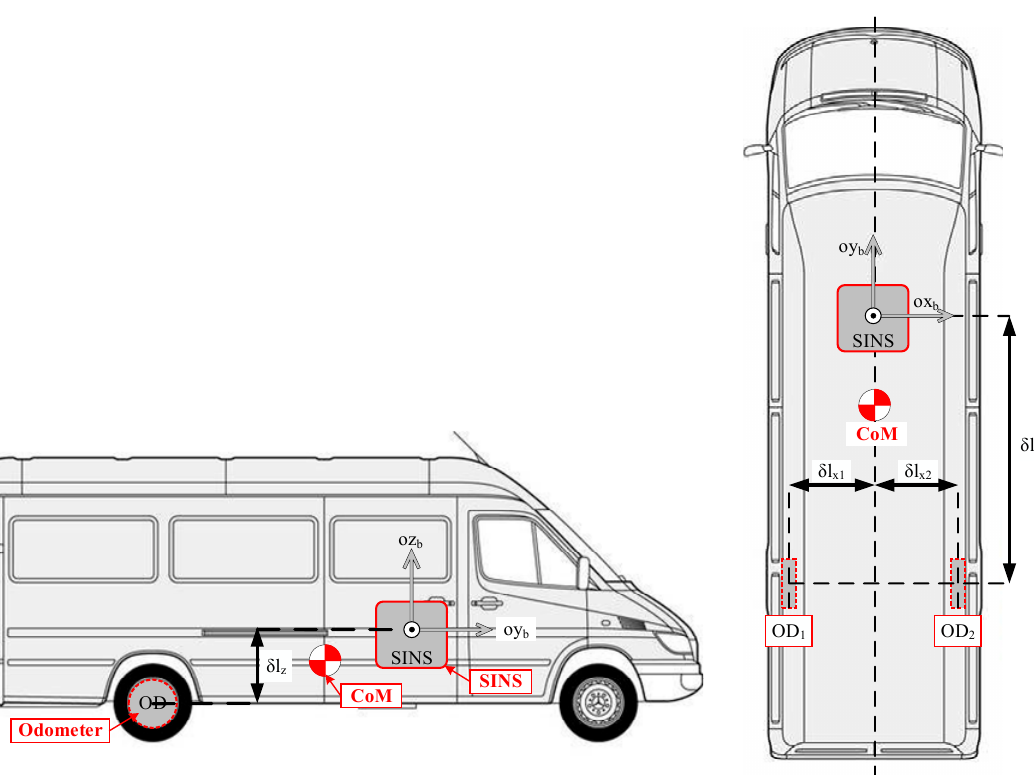
Figure 1. The configuration of the integrated navigation system.